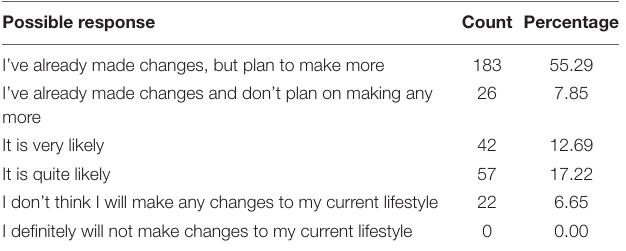
TABLE 2 | Counts and percentages ( n = 330) of how likely respondents are to make changes to their lifestyles within the next 12 months to benefit the sea, coast and climate, due to the reasons given in Figure 5